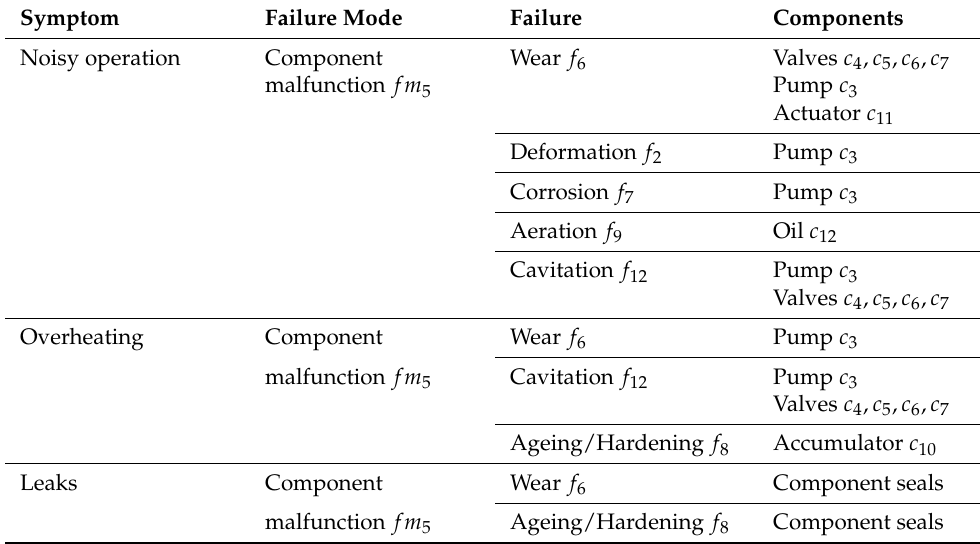
Table 3. Functional failures ( f f 3 ) . System is able to perform intended function with minor